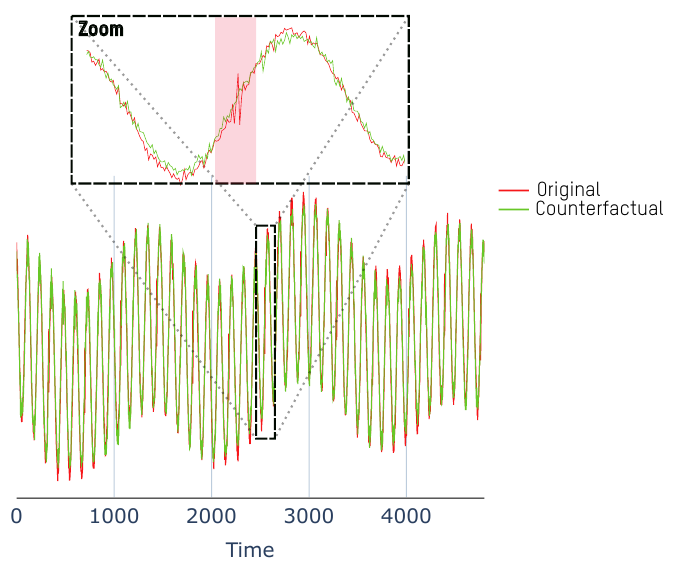
Figure 12. An anomalous sample and the counterfactual explanation for showing normal